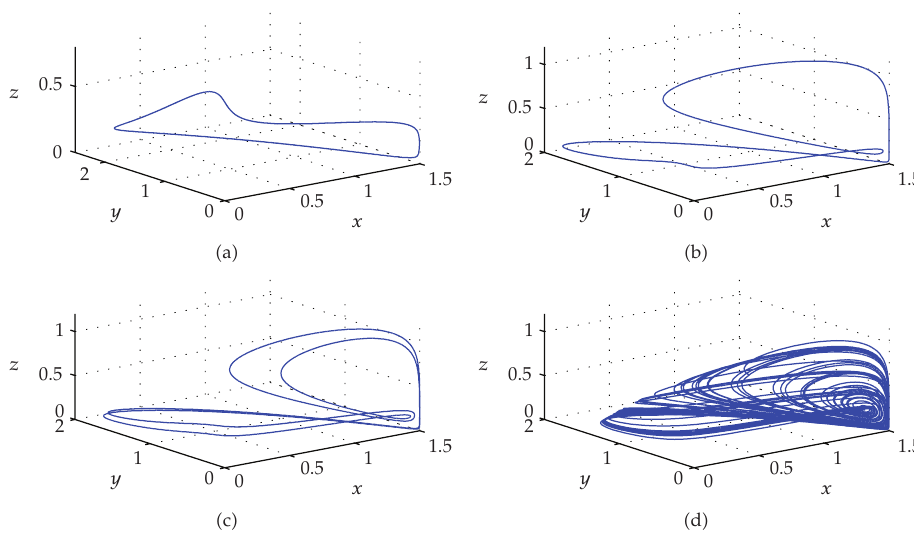
Figure 6: Period-doubling bifurcation: (cid:3) a (cid:6) attractor with period-1 when d 1 (cid:7) 0 . 15; (cid:3) b (cid:6) attractor with period- 2 when d 1 (cid:7) 0 . 22; (cid:3) c (cid:6) attractor with period-2 when d 1 (cid:7) 0 . 25; (cid:3) d (cid:6) chaotic attractor when d 1 (cid:7) 0 .